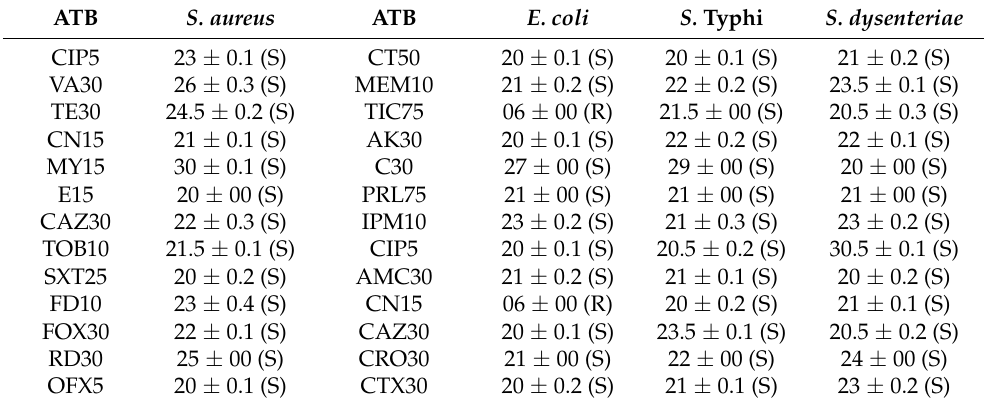
Table 5. Antibiotic sensitivity test for S. aureus , E. coli , S. Typhi, and S. dysenteriae . ATB S. aureus